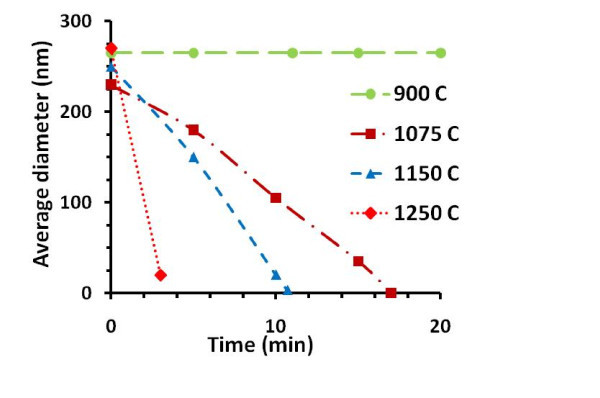
Plot of pore diameter vs time at different temperatures. This plot is based on TEM micrographs of different nanopores processed at different temperatures. No change in pore size is seen after 20 min at 900°C. The pore shrinkage rate increased with increasing temperature. Note: average diameter of the nanopore = sqrt (long axis × short axis). All the shrinking processes show almost linear shrinking behavior.